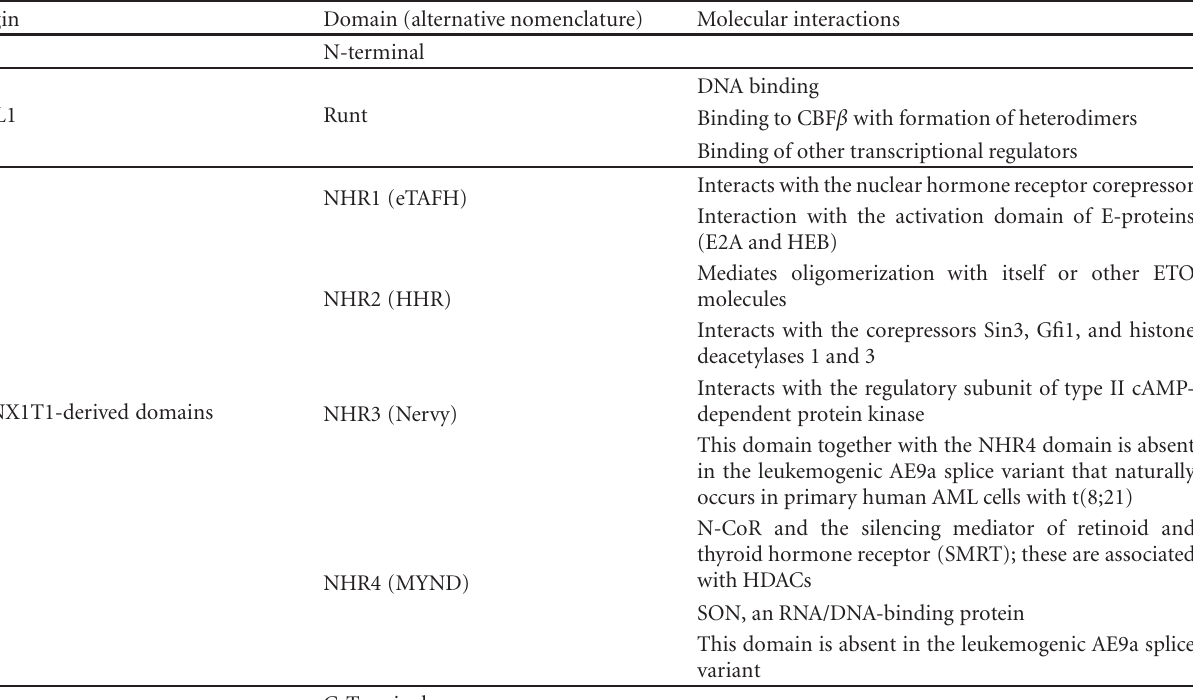
Table 2: Molecular structure of the t(8;21) fusion protein, the origin of various domains, and the localization of important molecular